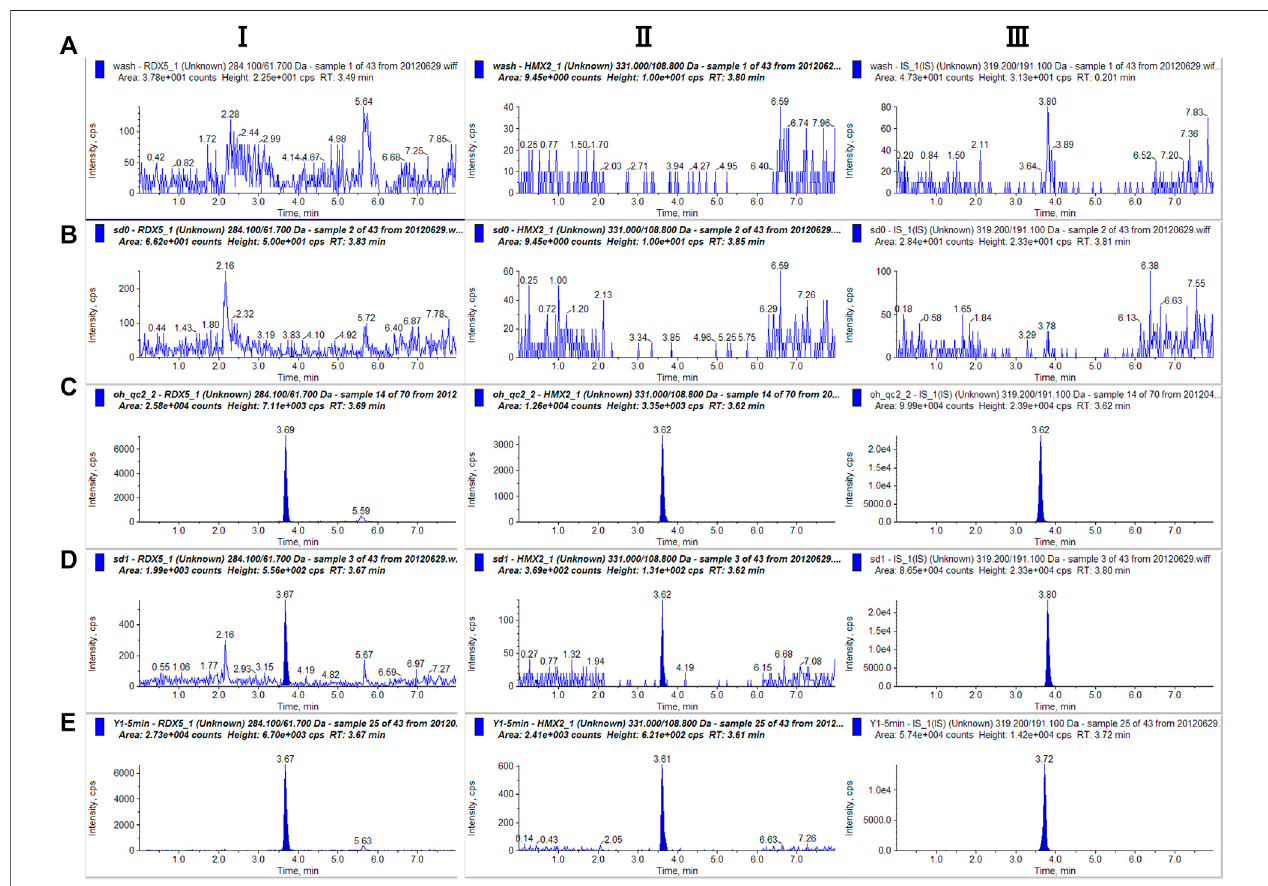
FIGURE 3 | Representative single reaction monitoring chromatograms of (A) blank solution (B) blank plasma (C) blank solution spiked with RDX (100.00 ng · ml − 1 ), HMX (100 ng · ml − 1 ) and IS (D) blank plasma spiked with RDX (100 ng · ml − 1 ), HMX (100.00 ng · ml − 1 ) and IS (E) a plasma sample 0 – 5 min after intravenous 0.5 ml mixted